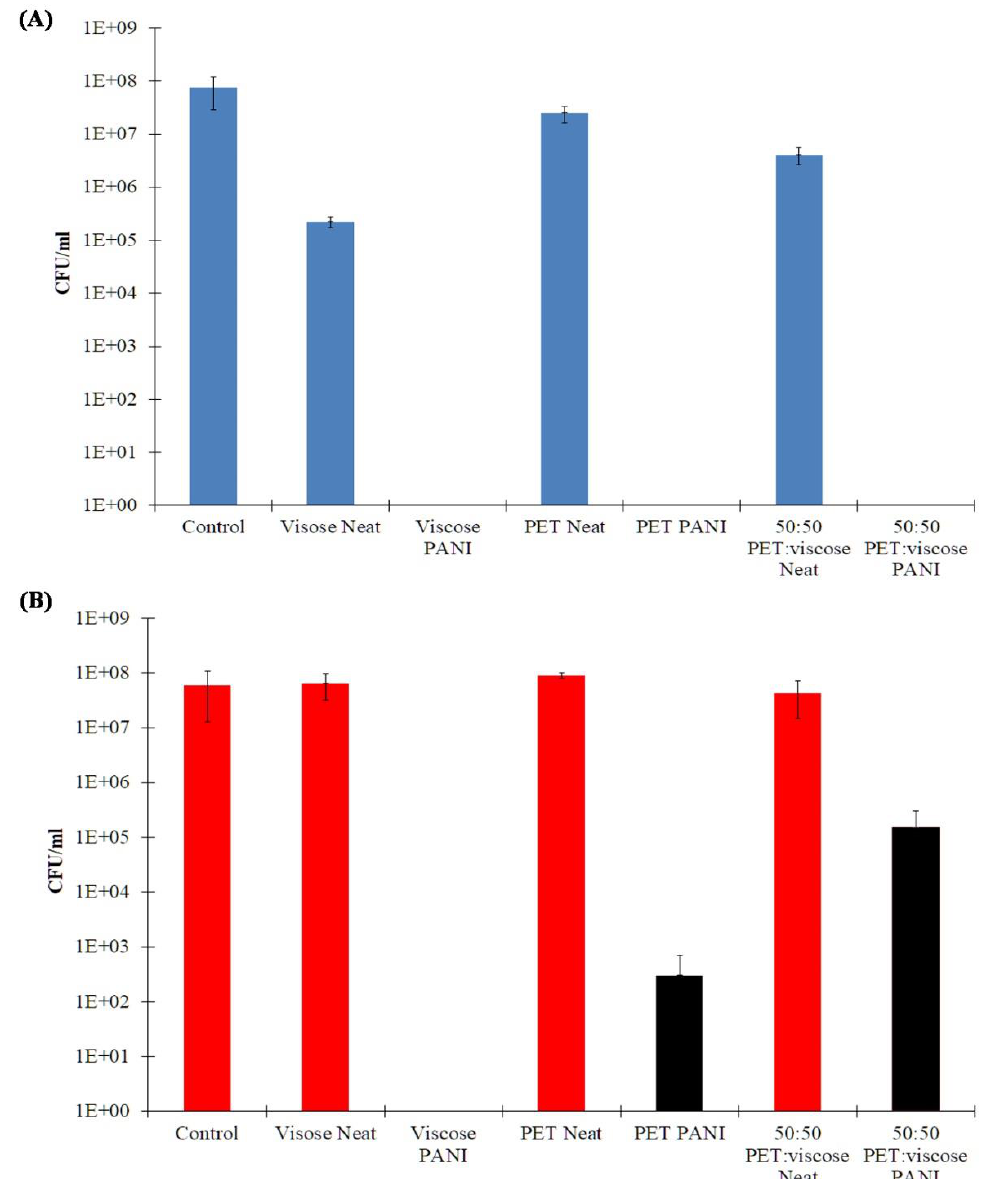
Figure 6. Antibacterial test results of neat and 44 mM PANI-coated viscose, PET and 50:50 PET:viscose fabrics against S. aureus ( A ) and S. epidermidis ( B ).